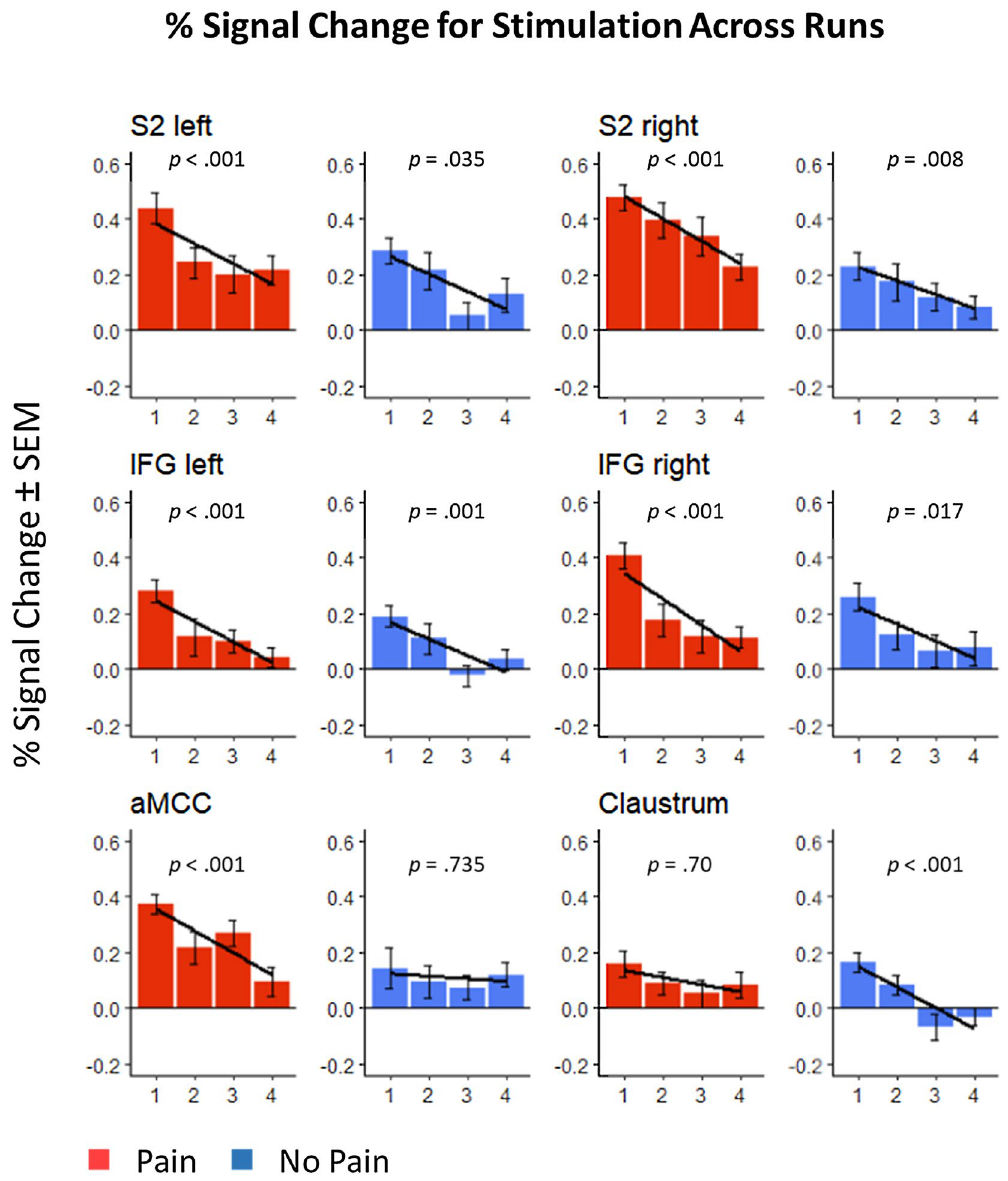
Figure 4. Contrast estimates of painful and non-painful stimulation over the four runs. This figure shows habituation effects within S2, IFG, aMCC and claustrum, comparing mean BOLD responses, separately for painful (red bars) and non-painful stimulation (blue bars). Black lines indicate a significant linear decrease over the four runs (p < 0.01). While there was a significant habituation to both kind of stimulations within bilateral IFG and right S2, habituation was found within the left S2 and the aMCC only for pain, while the claustrum showed habituation only to non-painful